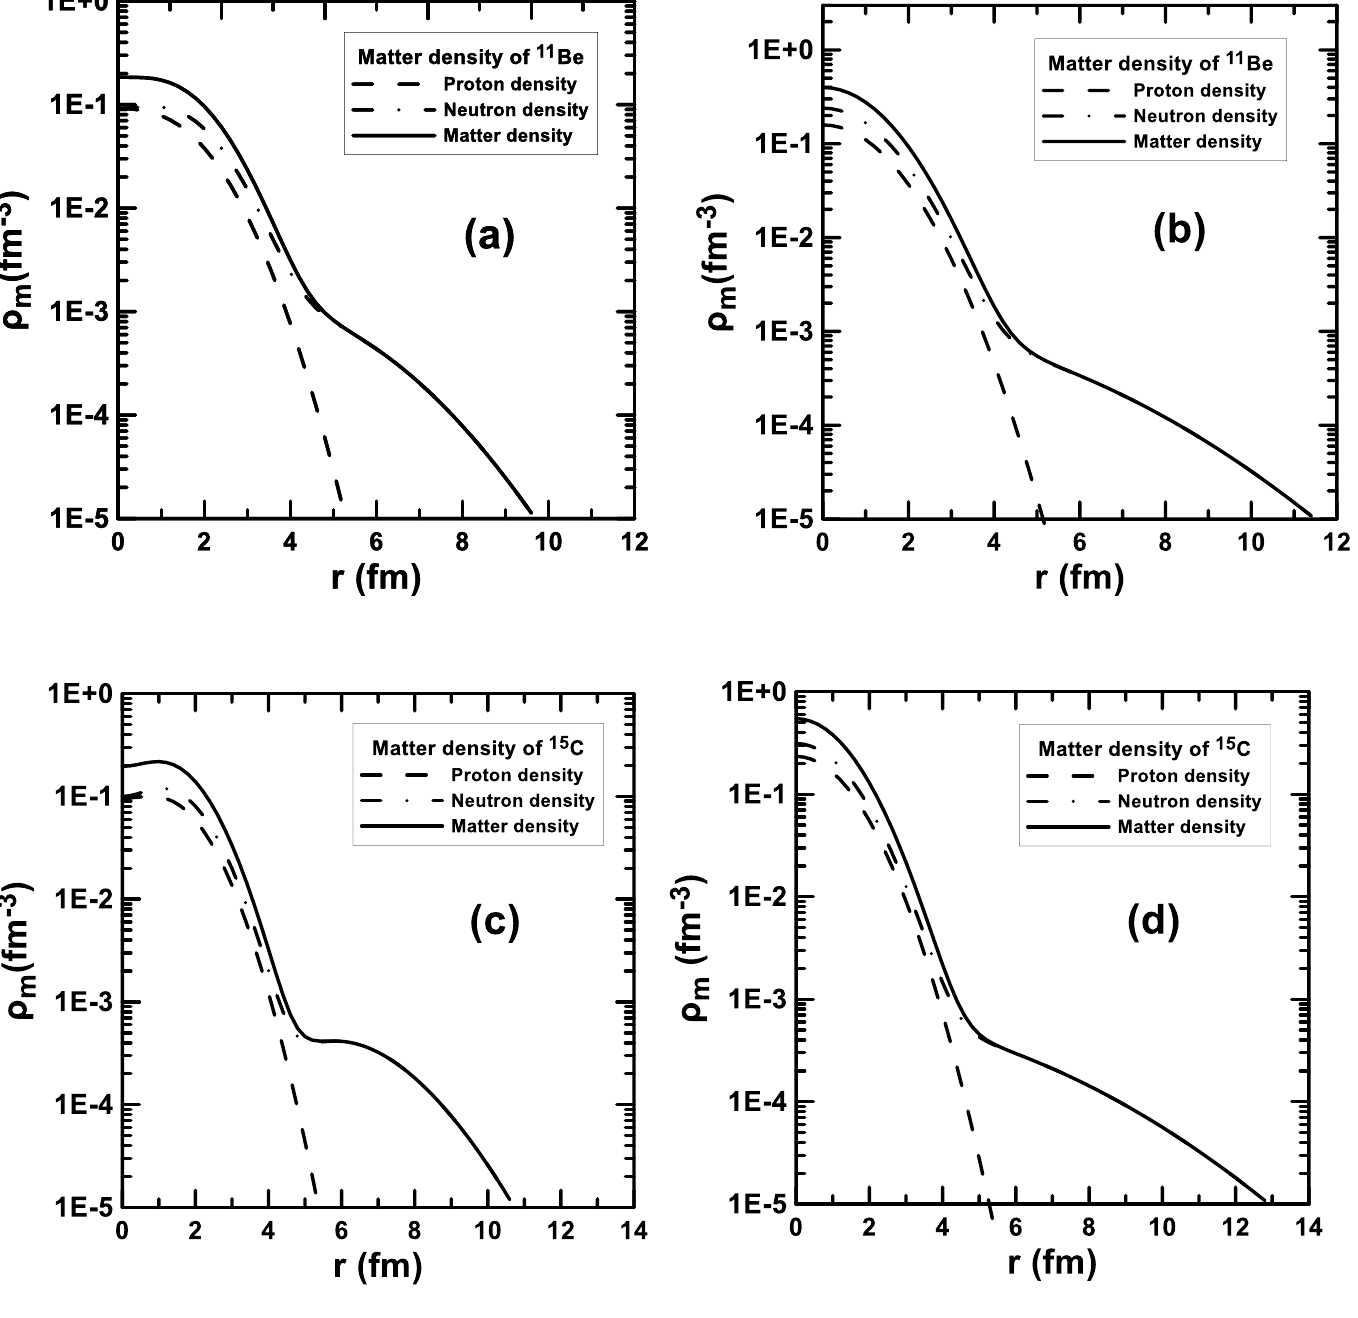
Fig.3: Neutron, proton and matter density distributions obtained via TFSM [Figs. (a) and (c)] and BCM [Figs. (b) and (d)]. The top and bottom panels correspond to halo nuclei B e 11 and , 15 C